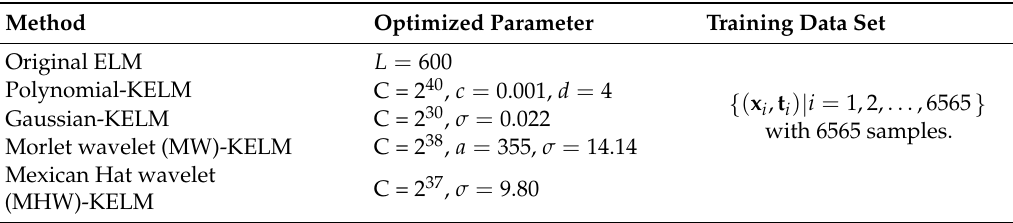
Table 1. Optimized parameters of the data-driven method.